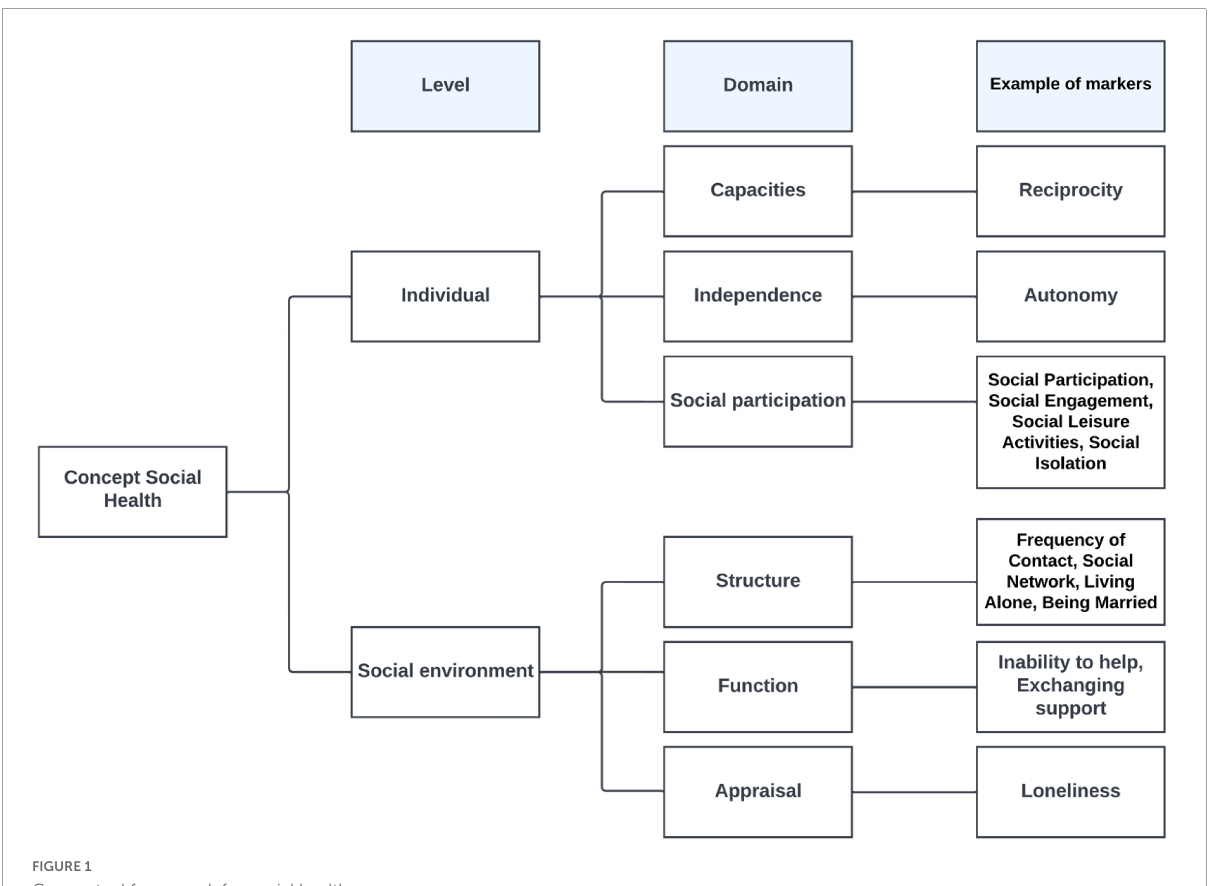
FIGURE1 Conceptual framework for social